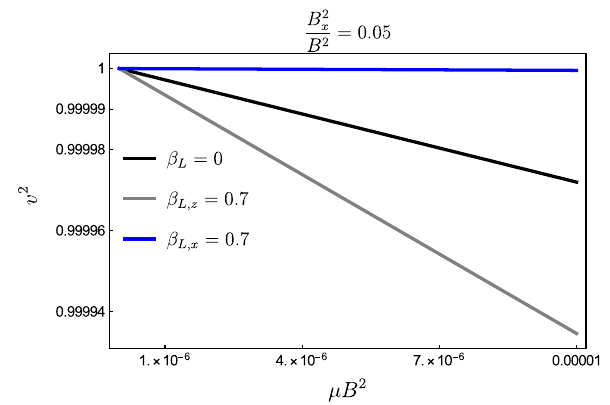
Fig. 5 The phase velocities for metric 1 are shown in three cases: v 1 forthemetricEq.(10)(black)andthenthecorrespondingtotheLorentz boost along the z (grey) and x (blue) directions. The slowing down is enhanced for the boost along the propagation